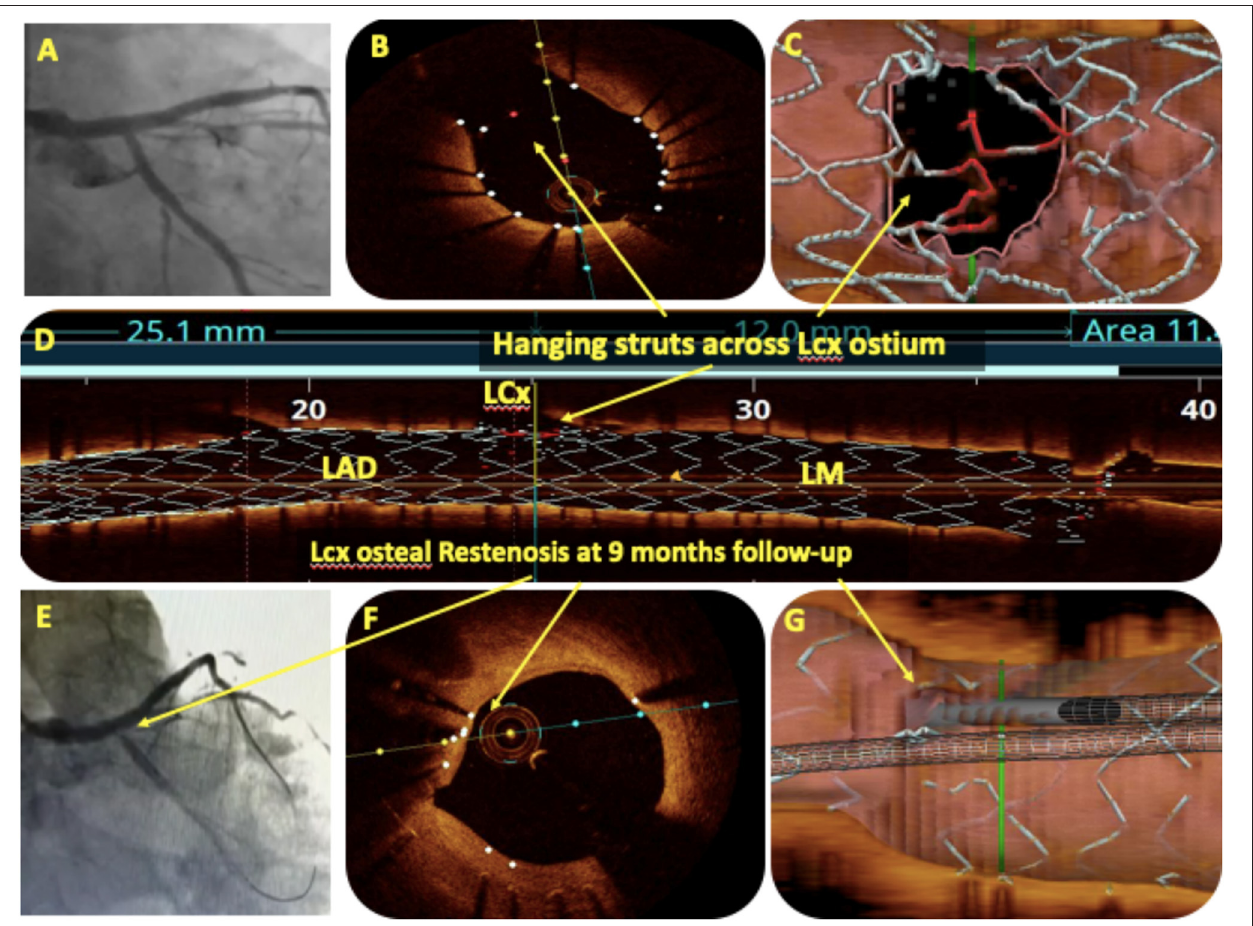
FIGURE 7 | OCT in bifurcation angioplasty. (A) Showed the final angiogram picture after LM bifurcation angioplasty with two stents using the DK crush technique. The angiographic result for LCx ostium was satisfactory but OCT pullback of the main branch (MB) after final kissing balloon inflation (KBI) showed hanging stent struts (red) across LCx ostium on the cross-sectional view (B) , on 3D reconstruction (C) , and on the rendered stent view (D) . The same patient presented with crescendo angina after 9 months, and angiography showed LCx ostial ISR (E) . OCT pullback of MB showed complete endothelization of hanging stent struts across LCx as a cause of ostial ISR (F,G)